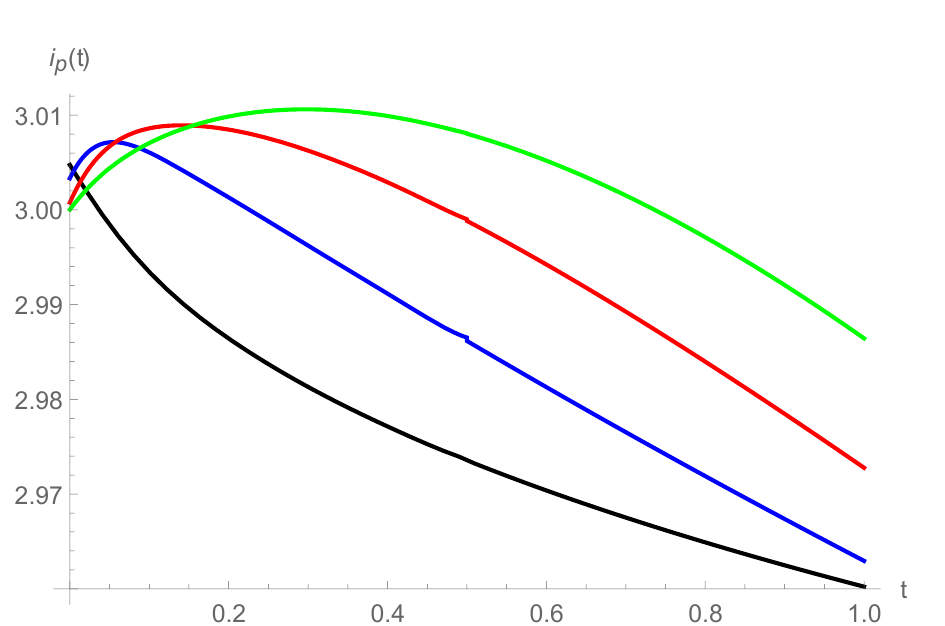
Figure 9. The effect of υ on the distribution of i p ( t ) . Black: υ = 0.2, Blue: υ = 0.4, Red: υ = 0.6, Green: υ = 0.8.